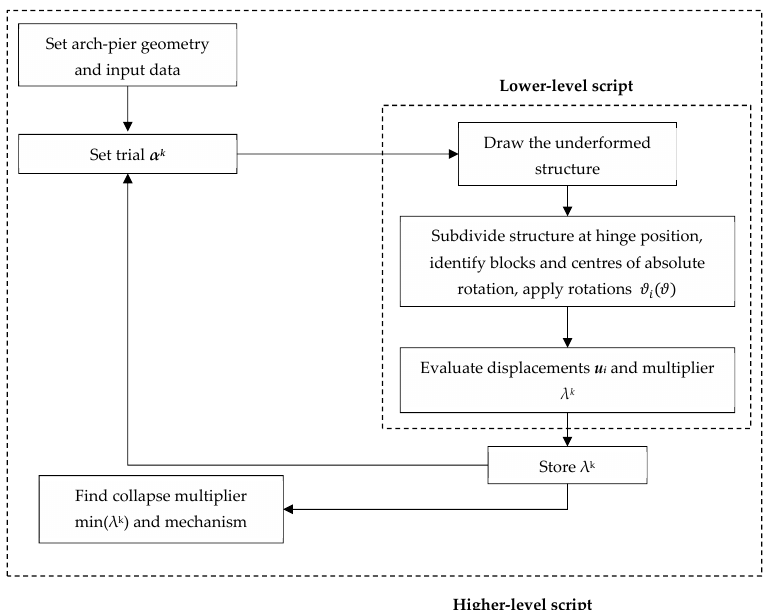
Figure 3. Flowchart of the Gmsh scripts to evaluate the arch collapse multiplier.